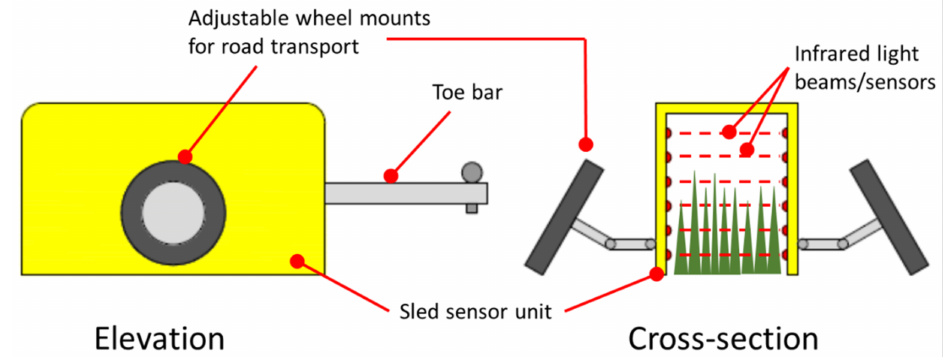
Figure 6. Elevation and cross section schematic of the C-DAX